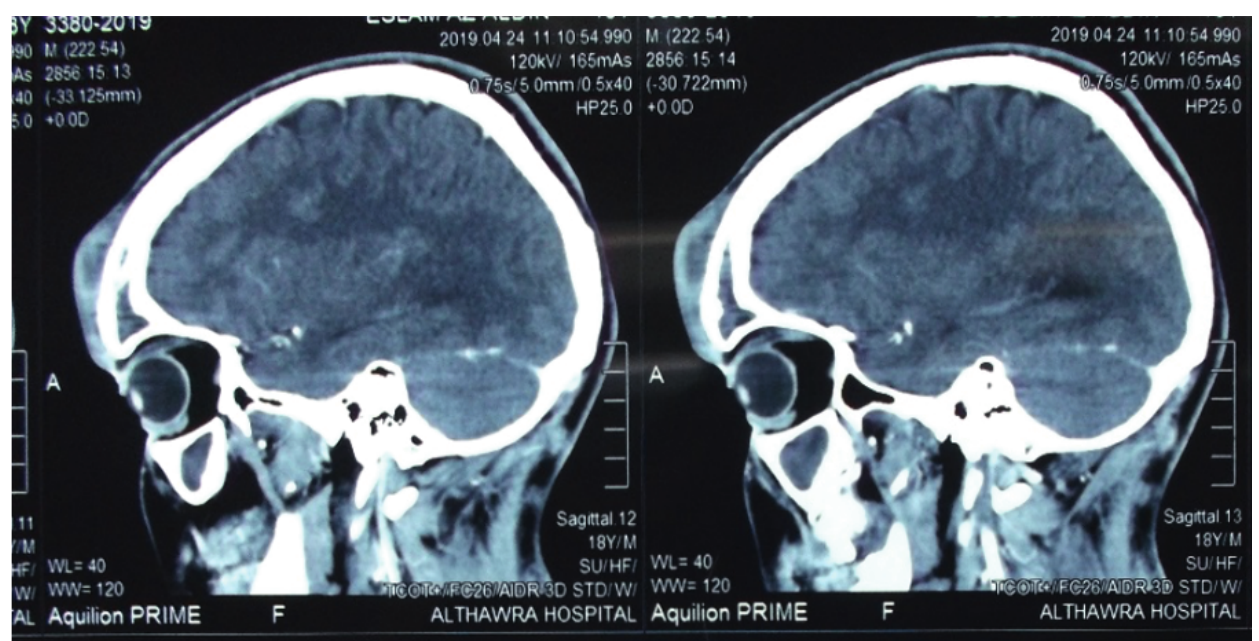
Figure 2. Sagittal CT- sections demonstrate the sub-periosteal abscess